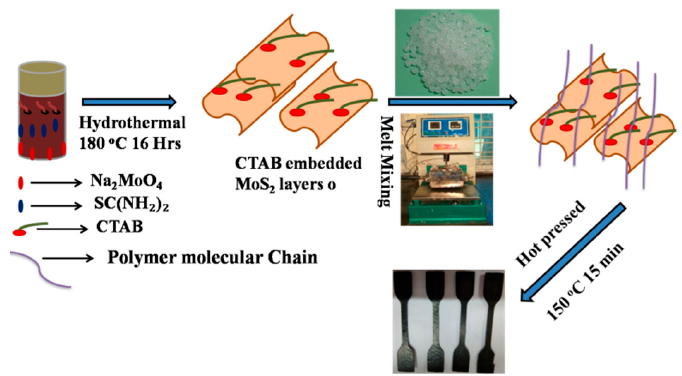
Figure 1. Schematic for the functionalization of MoS 2 by cetyltrimethylammonium bromide (CTAB) and preparation of linear low-density polyethylene (LLDPE) composites by melt mixing.